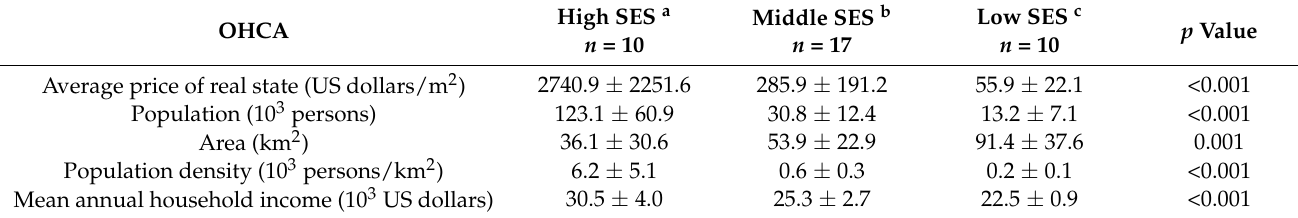
High SES a Low SES c Middle SES b p Value n = 10 n = 10 n = 17